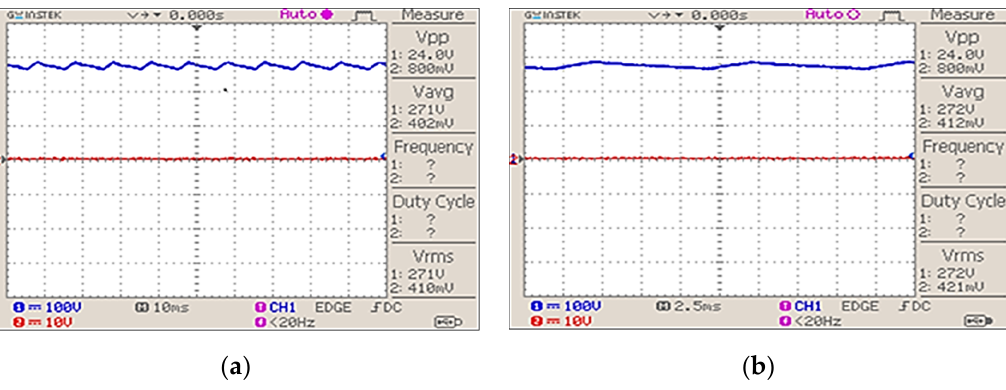
Figure 13. The observed output voltage of the interleaved Luo converter at ( a ) the initial time and ( b ) running time.